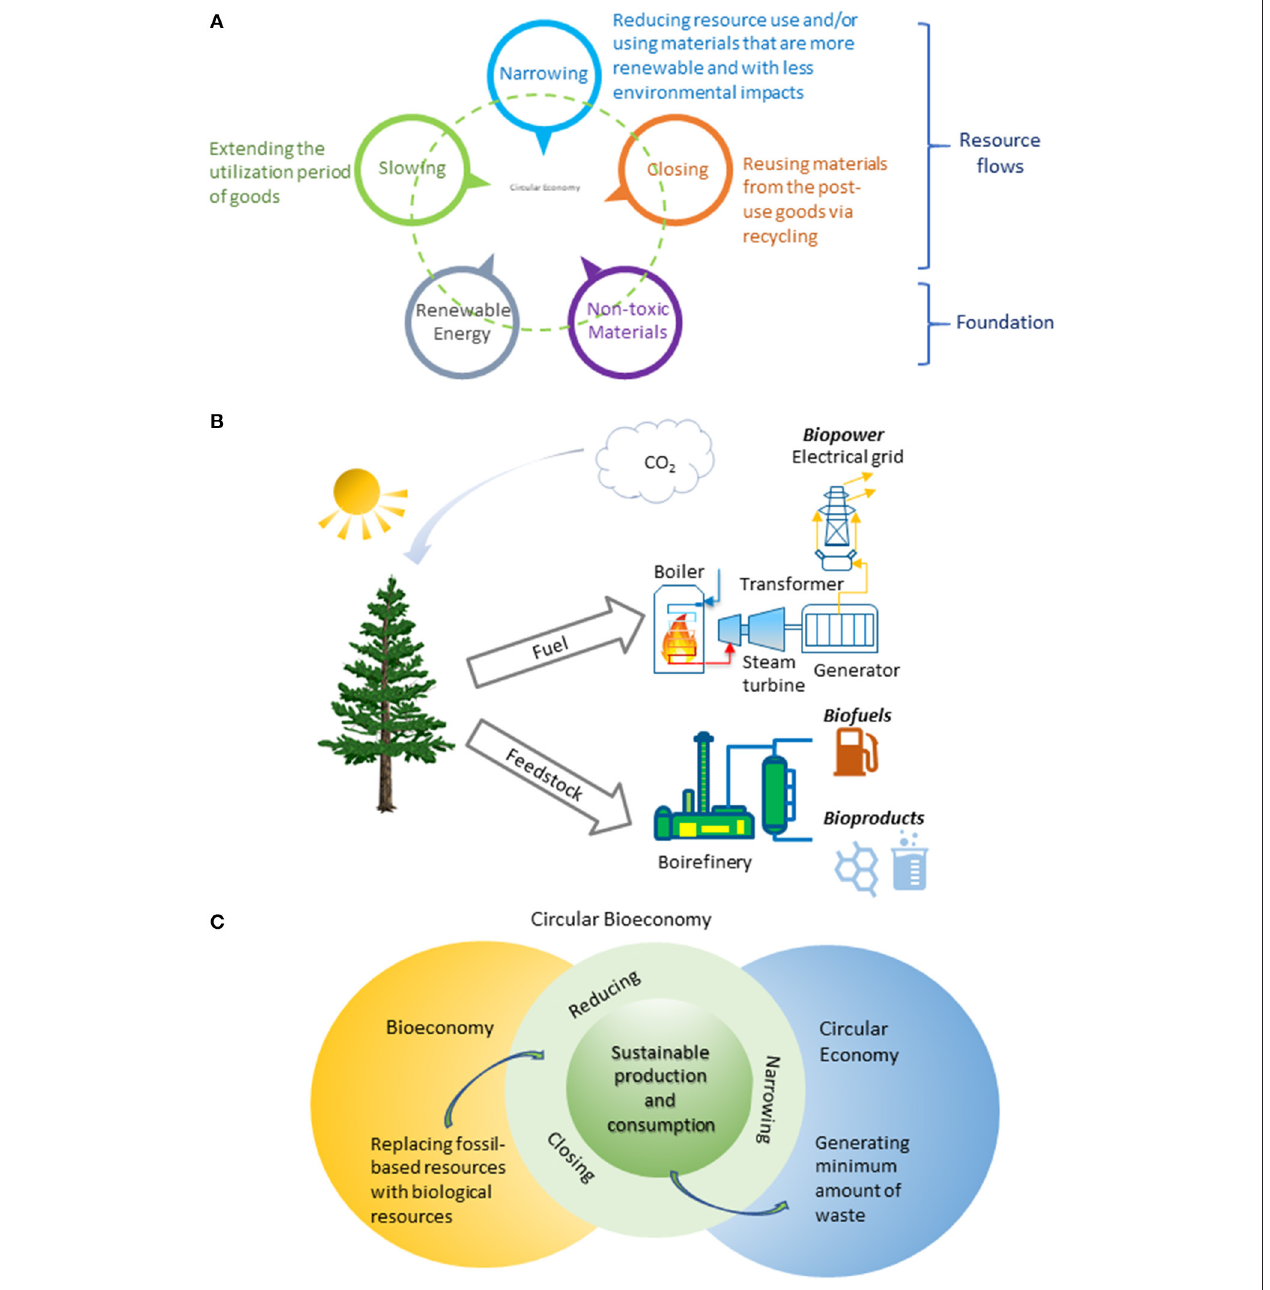
FIGURE 1 | (A) Components of a proposed working circular economy definition; (B) Schematic representation of a sustainable bioeconomy—renewable biological resources to renewable products (i.e., biopower, biofuels, bioproducts); (C) Schematic representation of a circular bioeconomy resulting from the intersection between circular economy and bioeconomy